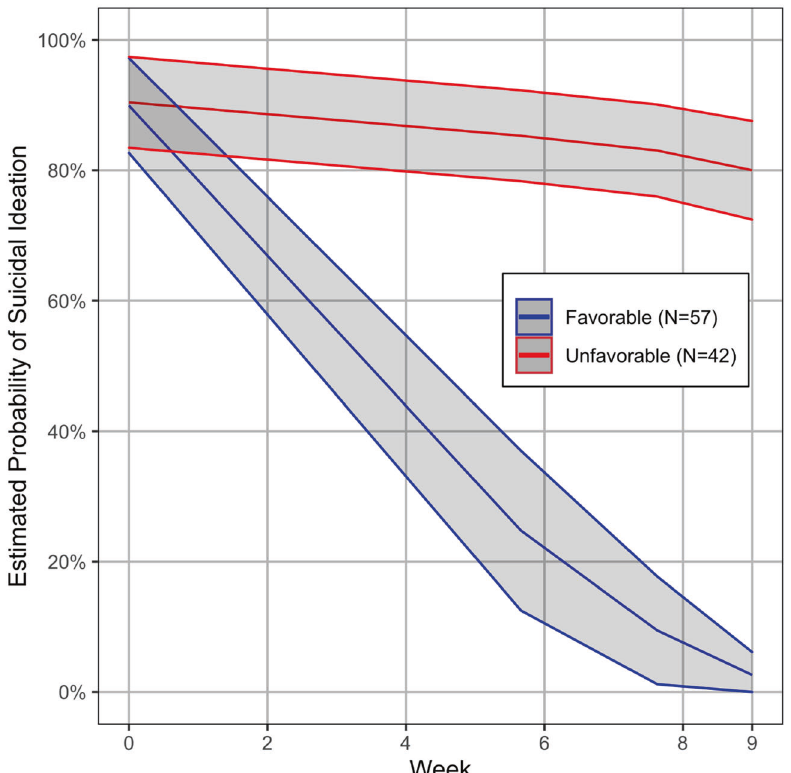
Fig. 3 Latent growth mixture model (LGMM) estimated growth curves of the presence of suicidal ideation in 99 older adults with major depression and suicidal ideation at baseline randomly assigned to “ Engage ” or Problem-solving therapy. The fi gure presents two LGMM trajectories with 95% CI of the probability of the presence of suicidal ideation over 9 weeks. Red color represents an unfavorable (42% of participants) and blue color represents a favorable trajectory of suicidal ideation (58% of participants). The presence of suicidal ideation at baseline and during the treatment trial is de fi ned as a score of 1, 2, or 3 in the Suicide item of the 24-item Hamilton Depression Rating Scale.